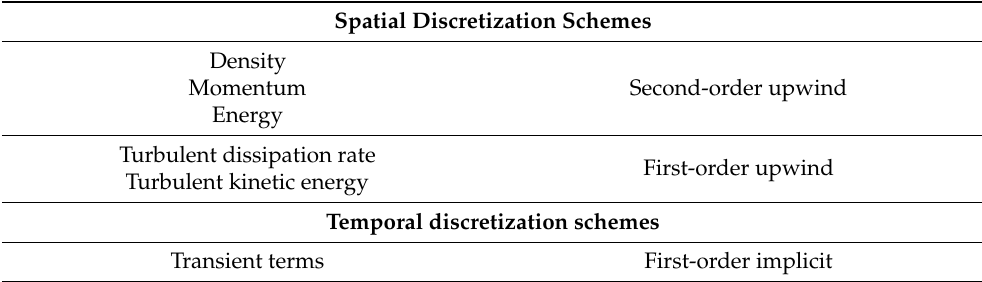
Table 3. Spatial and temporal discretization